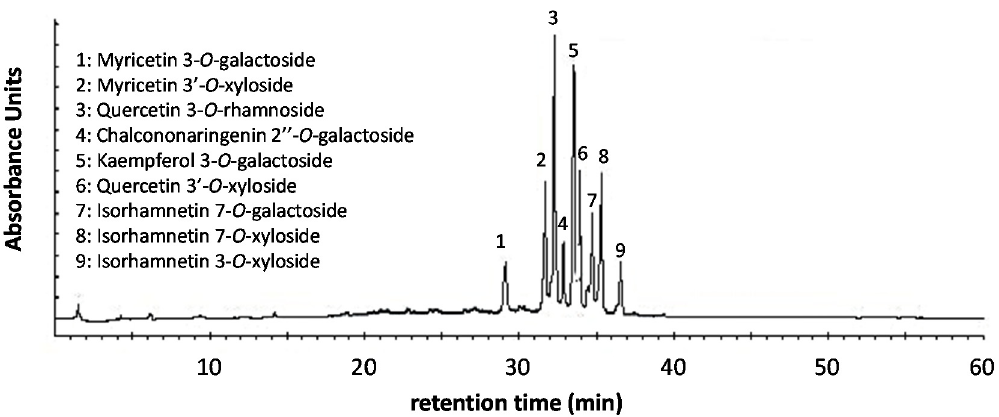
Figure 5. Representative LC chromatogram of extract from N. lotus stamens prepared by UAE followed by MPR purification step recorded at 350 nm.